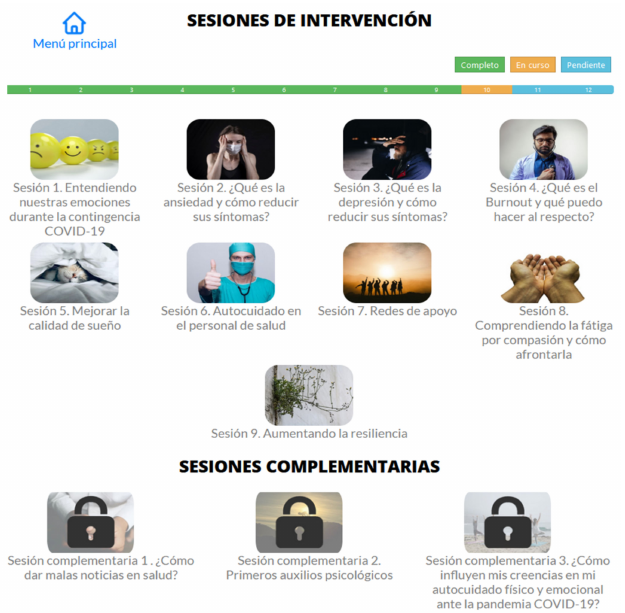
Figure 6. Screen with all the available sessions or